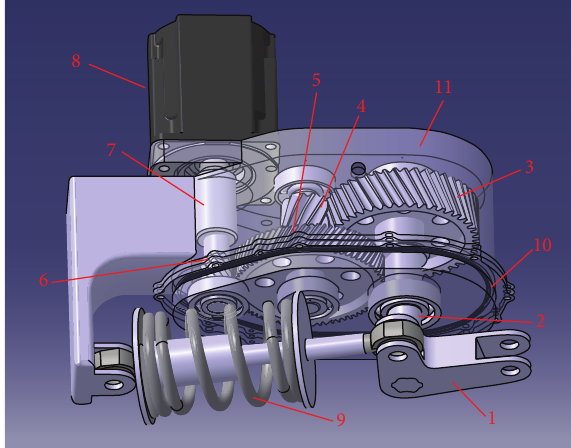
Figure 3: Gearbox type actuator. (1) Bell crank; (2) output shaft; (3) second-stage driven gear; (4) second-stage driving gear; (5) first- stage driven gear; (6) first-stage driving gear; (7) input shaft; (8) PMSM; (9) spring; (10) Shell 1; (11) Shell 2.